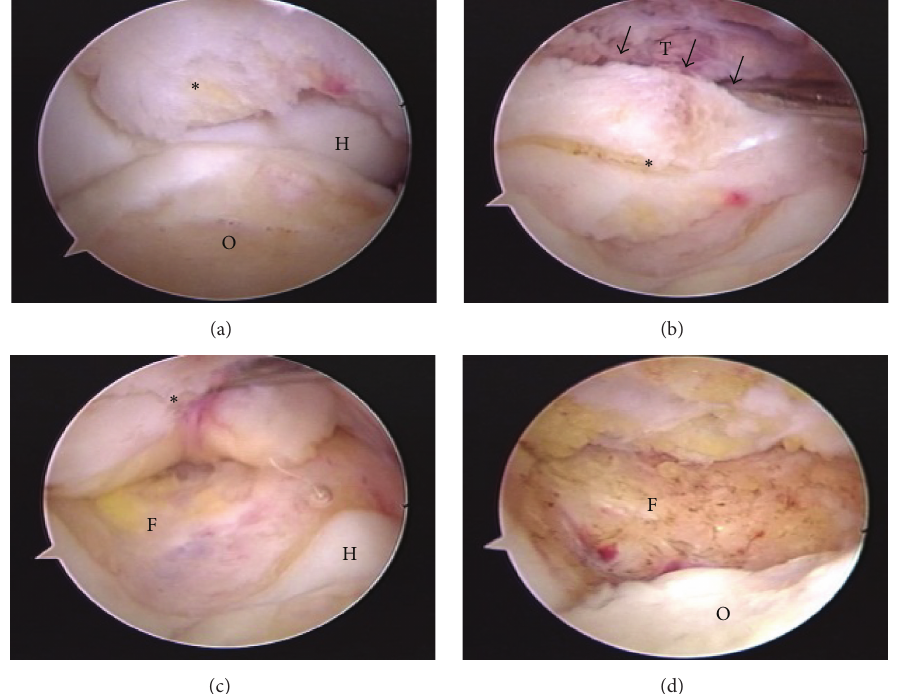
Figure 2: Posterior arthroscopic view of the left elbow. (a) The olecranon fossa is covered by the fat pad (asterisk). (b) The fat pad is partially detached from the rest of the fat pad. (c) The olecranon fossa is visible when the fat pad is pulled upwards. (d) View after debridement of the posterior fossa of the elbow. O: olecranon; H: humerus; T: triceps; F: olecranon fossa. Image views: top: proximal; left: lateral; right: medial; bottom: distal.